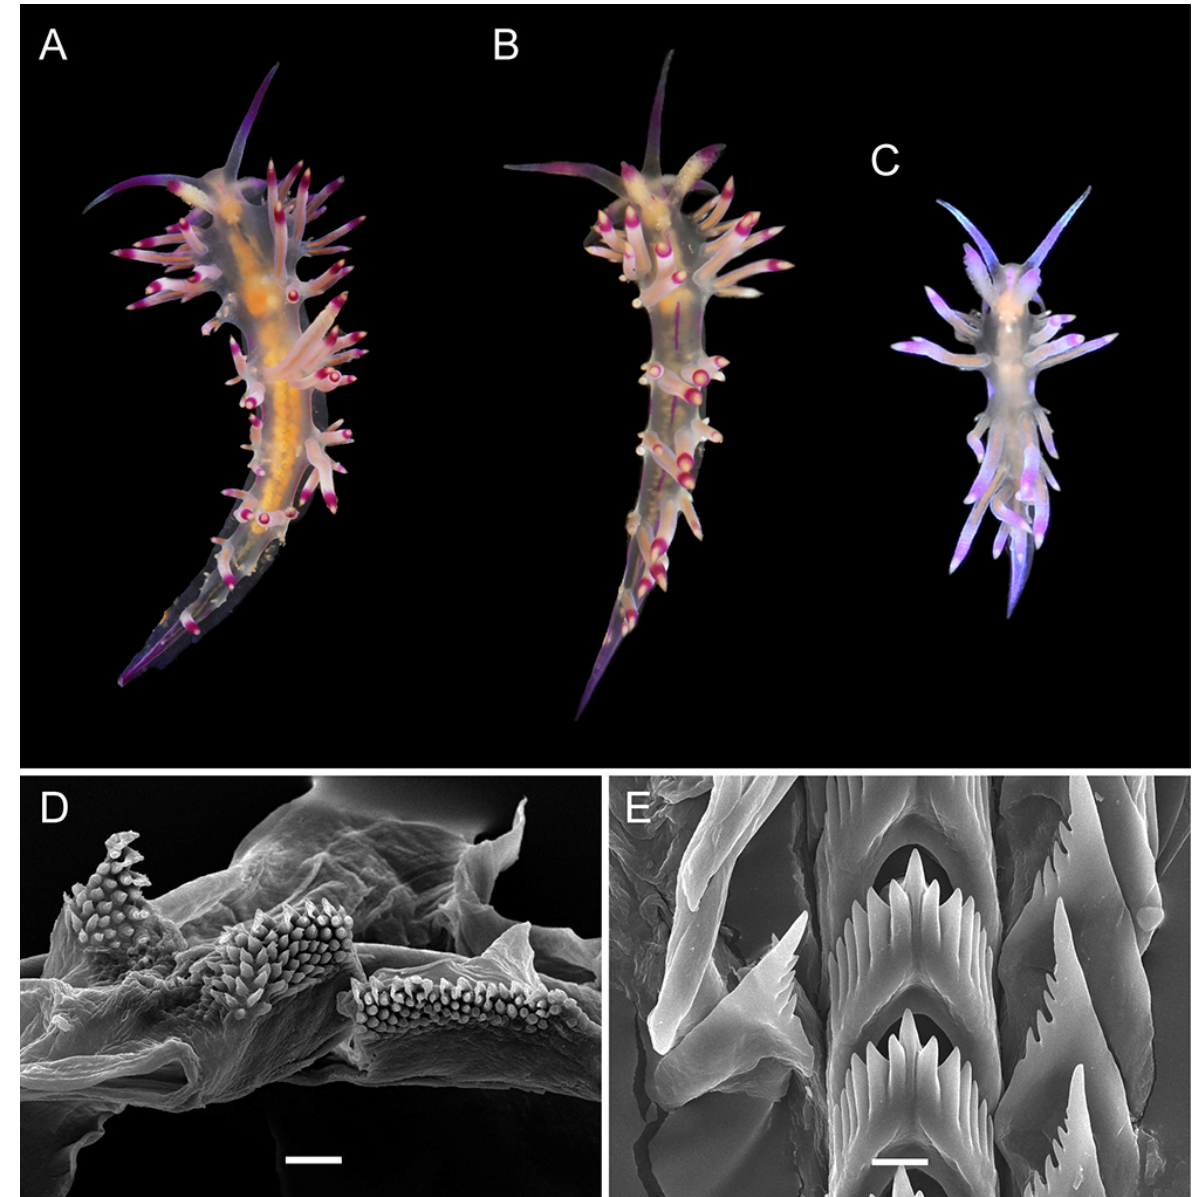
Figure 8. Coryphellina pseudolotos sp. nov., external morphology and buccal armature. ( A )—holotype ZIN63213, specimen 15 mm in length (preserved). ( B )—paratype ZIN63215, specimen 12 mm in length (preserved). ( C )—paratype ZIN63214, specimen 7 mm in length (preserved). ( D )—paratype ZIN63215, masticatory border of jaws. ( E )—paratype ZIN63215, posterior radular portion. Scale bars: ( D ) = 20 µ m; ( E ) = 10 µ m. Photo credits: ( A , B ): Elena Mekhova; ( C ): Tatiana Antokhina. Color (Figures 4 and 8A–C): Background color translucent. Digestive gland diverticula in cerata from peachy to light brown. Cerata translucent white, red to violet subapical rings with sparse white opalescent speckling underneath, white to peachy cnidosac area. Short pink to violet line between oral tentacles, line on body discontinuous in some specimens indistinct. Pink to violet discontinuous lines located laterally in ceratal intergroup space under notal edge, continuing from head to tail. Tail pink to violet. Rhinophores same color as body or light yellow, violet, or purple subapical rings. Oral tentacles pink to violet, more intensive in middle, white or translucent tip.